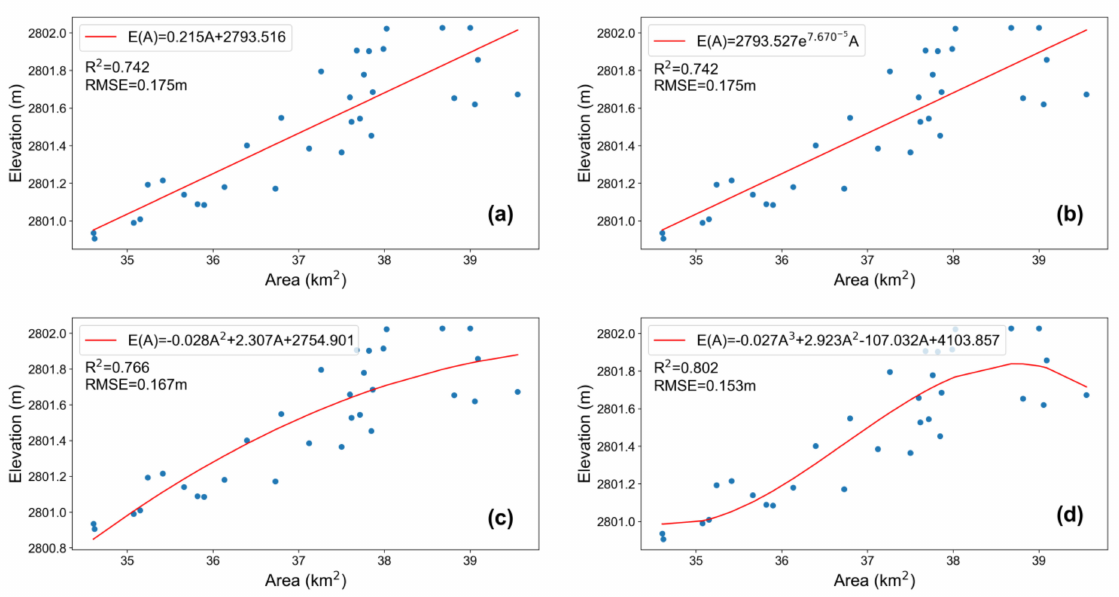
Figure 9. Gahai Lake water level plotted versus lake area: ( a ) linear curve, ( b ) exponential curve, ( c ) quadratic curve and ( d ) cubic